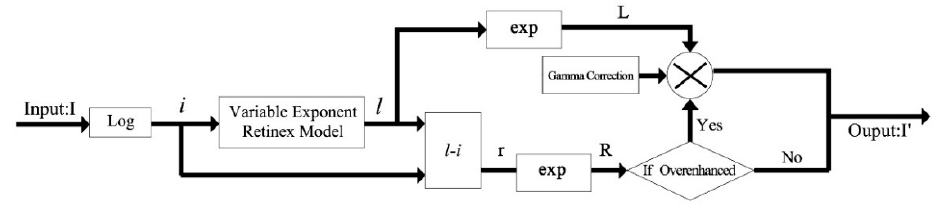
( f ) Figure 7. Synthetic example. ( a , d ) original image; ( b , e ) simulated illumination; ( c , f ) synthetic image.